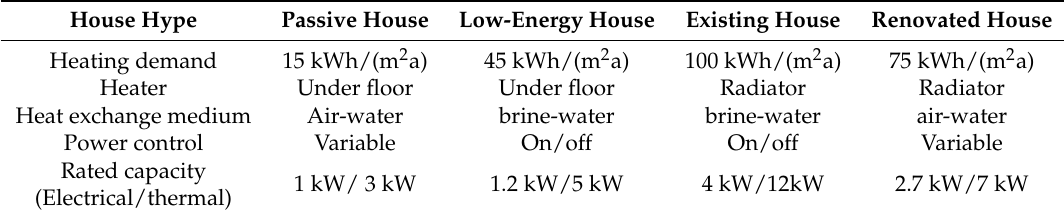
Table 1. Building study cases which represent typical households in Austria. During the modeling stage of these houses, they only contained single-phase loads. To perform effective demand response, they had to be upgraded to include various other flexibilities such as single/three-phase heat pumps, controllable loads, electric storage, and PV system with three-phase inverters. Some of the important specifications such as heat demand, control method, and rated capacities which influences the control scheme are provided in this